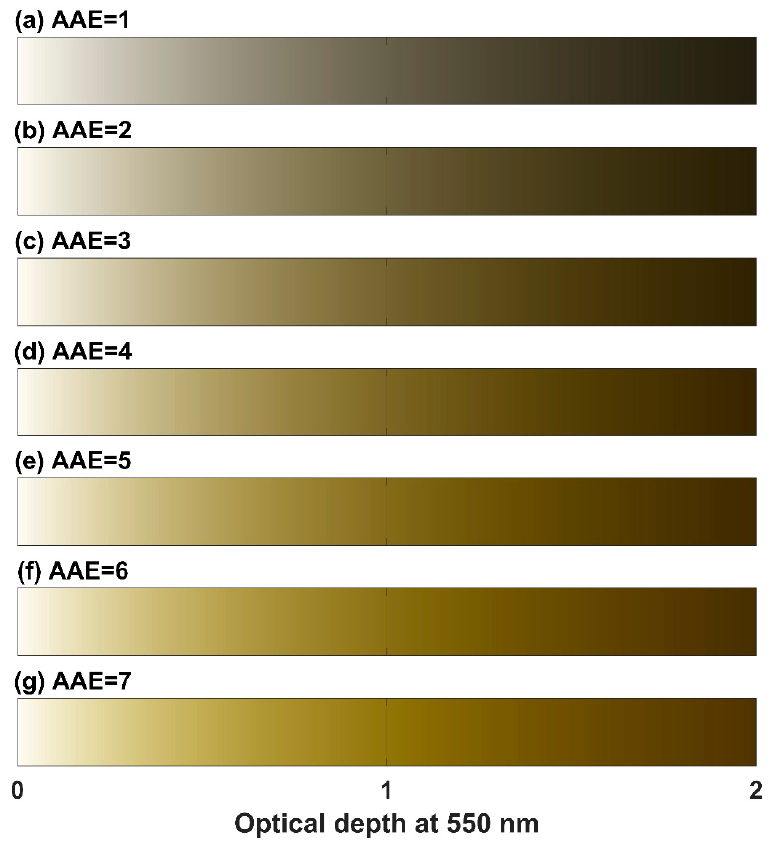
Figure 6. ( a – g ) show the seven series of colors of aerosols corresponding to AAE values from 1 to 7. The particle geometric mean diameter of aerosol layers is 0.1 μ m.